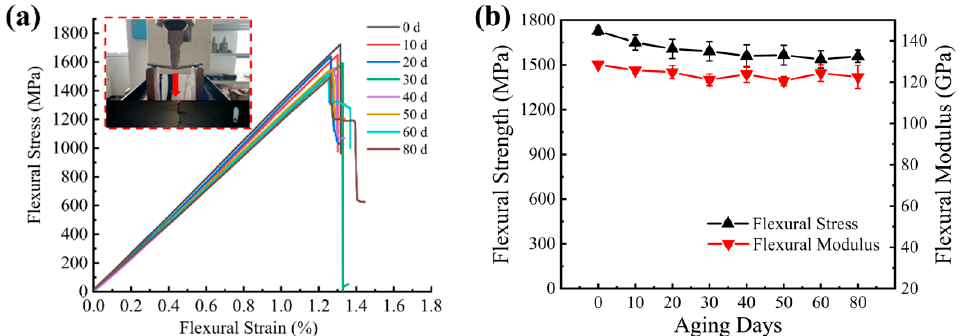
Figure 16. ( a ) Longitudinal direction flexural stress–strain curve; ( b ) longitudinal direction flexural strength/modulus versus UV aging time curve. strength/modulus versus UV aging time curve.